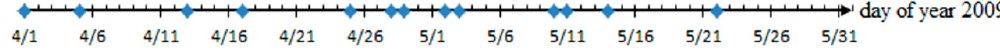
Figure 2. Temporal distribution of the images used from the two months. Each spot represents an acquired image.